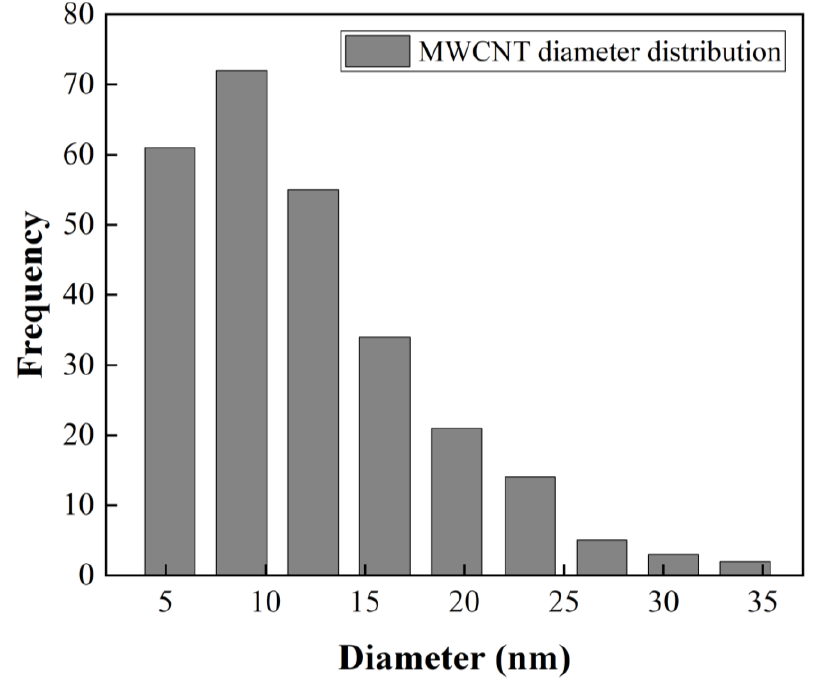
Figure 3. Statistical analysis of MWCNT diameter distribution from SEM image (Figure 2d).